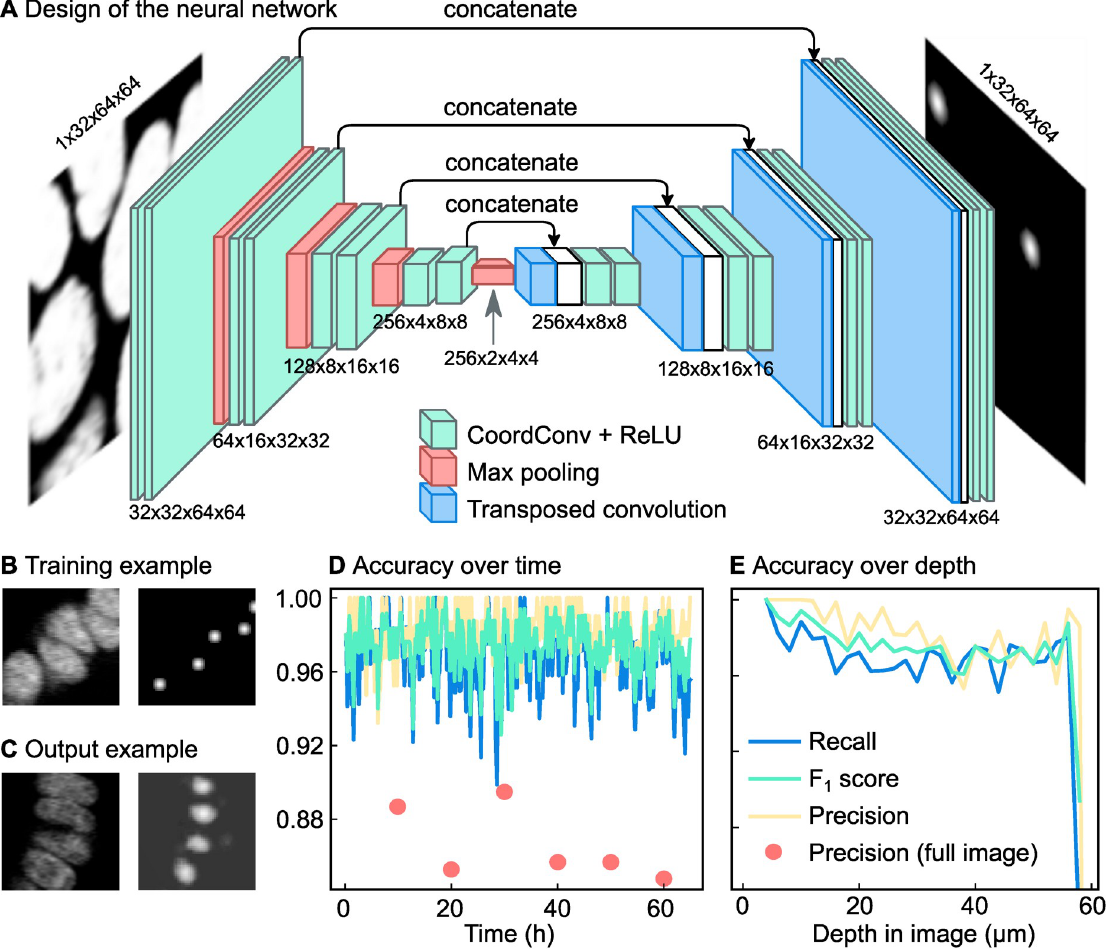
Fig 3. Automated detection of cell nuclei by a convolutional neural network. ( A ) Schematic overview of the network. The network is a standard convolutional network with absolute pixel coordinates added as input values. This makes it possible to adjust its detection network both for cells deep inside the organoid and cells near the objective. ( B ) Example of training data. On the left a slice of a 3D input image, on the right Gaussian predictions created from manual tracking data. The brightness of each pixel represents the likeliness of that pixel being the nucleus center. ( C ) Example of a network prediction, which shows the probability of each pixel being a nucleus center, according to the neural network. ( D ) Accuracy of the neural network over time compared to manual tracking data obtained in a subsection of a single organoid. For six time points (annotated with red circles) tracking data was compared to manually annotated data for an entire organoid. In this case, we observed a lower precision. For this organoid, the recall is 0.97 while the precision is 0.98. ( E ) Same data as in Panel d, now plotted over z. The accuracy of the network drops at the deepest imaged parts, likely because part of each nucleus falls outside the image stack here.